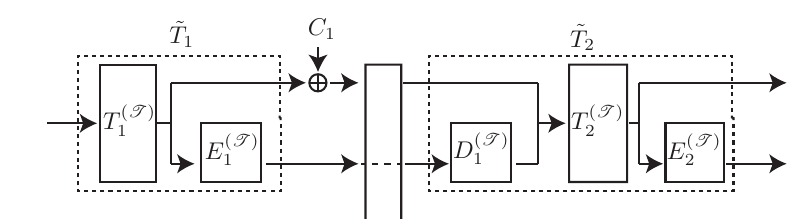
Figure 8: Relationship between T ( T )